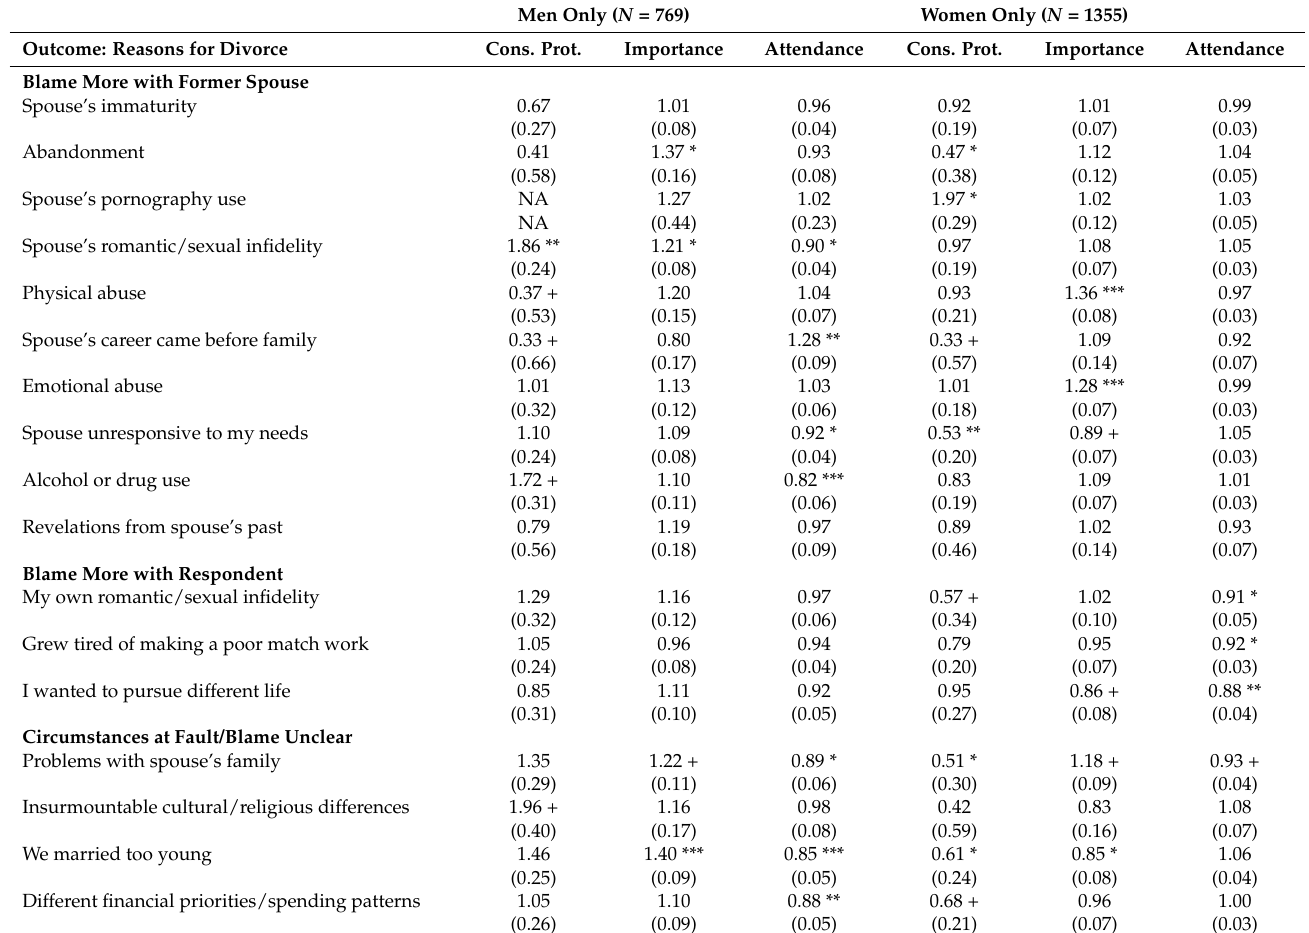
Table 4. Binary logistic regression models predicting retrospective reasons for